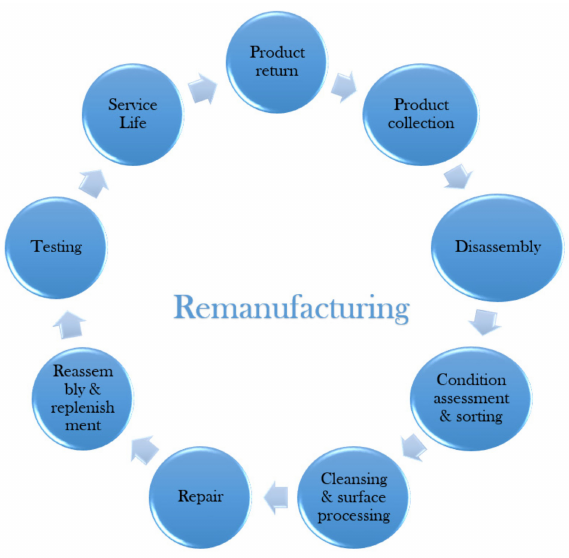
Figure 4. Major steps involved in remanufacturing (modified from